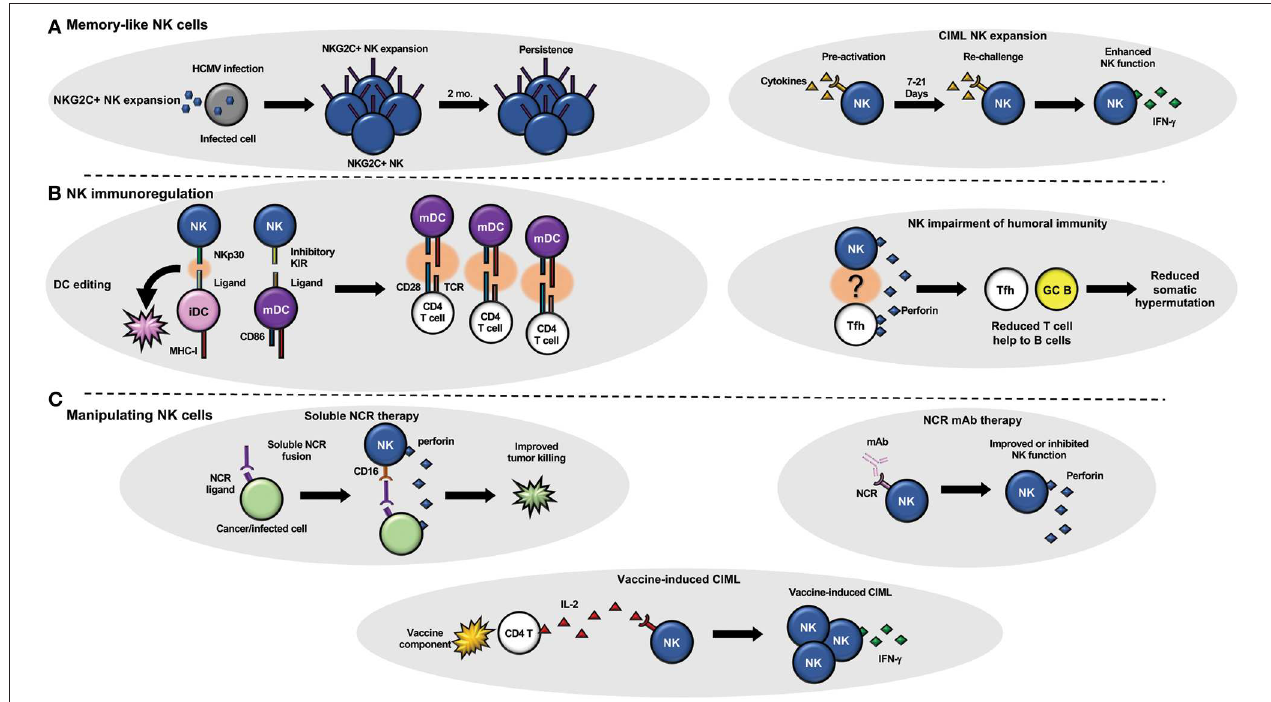
FIGURE 1 | NK cells and adaptive immunity. (A) NK cells can develop memory-like attributes in response to infection (left) or cytokine stimulation (right). (B) NK cells have been shown to regulate adaptive immunity by targeting dendritic cells (left) that can change the quality of the T cell response and T follicular helper cells (right) that can regulate B cell maturation (somatic hypermutation) and function. (C) Therapeutic manipulation of NK cell function using soluble NK cell receptors that target tumor or viral infected cells to improve NK cell targeting (top left) or monoclonal antibodies that block or stimulate NK cell receptors (top right) to modulate NK cell function are under current development. Vaccine components such as adjuvants (bottom) could also be utilized to generate CIML NK cells in vivo with a